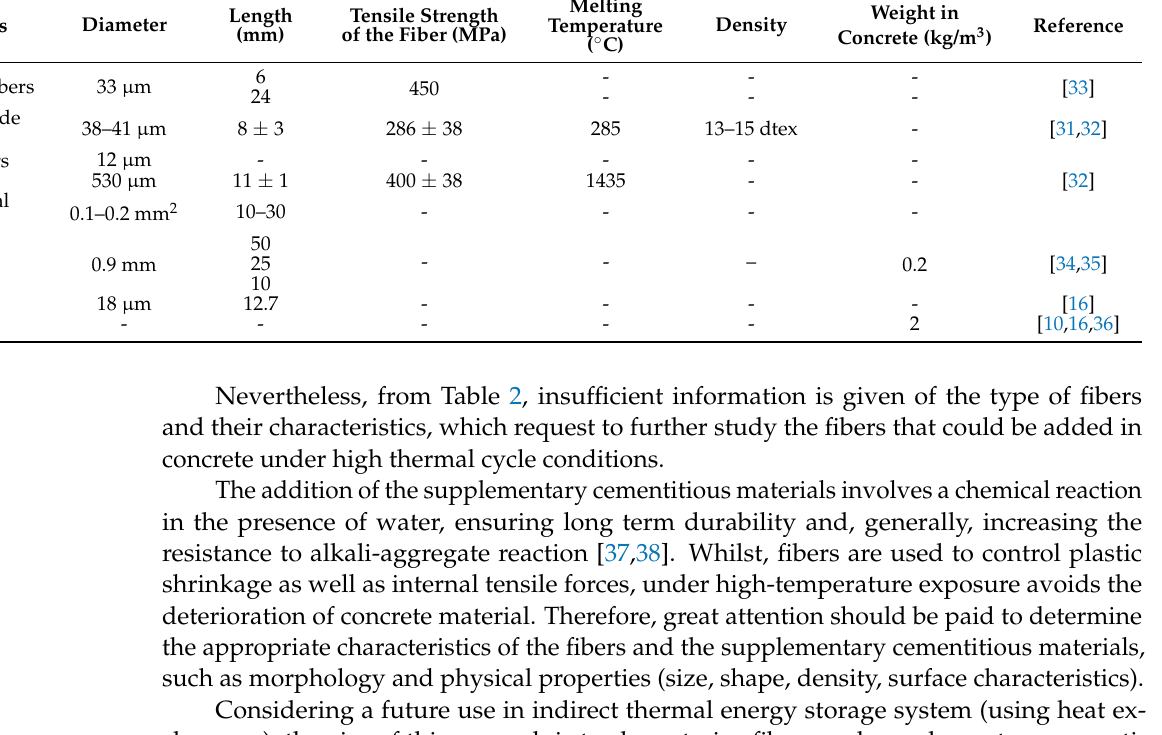
Table 2. Types and characteristics of fibers used in concrete for TES in CSP plant application Type of